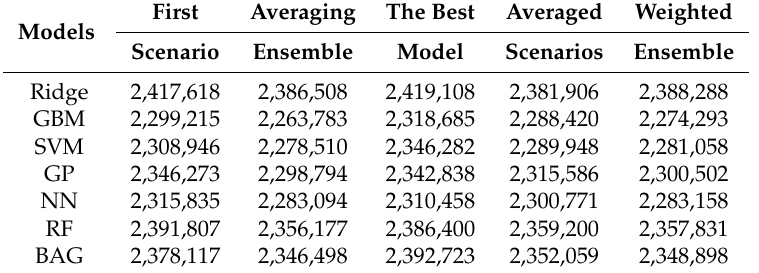
Table 4. The performances of various NWP ensemble methods are measured by the MAE in Wh/m 2 .